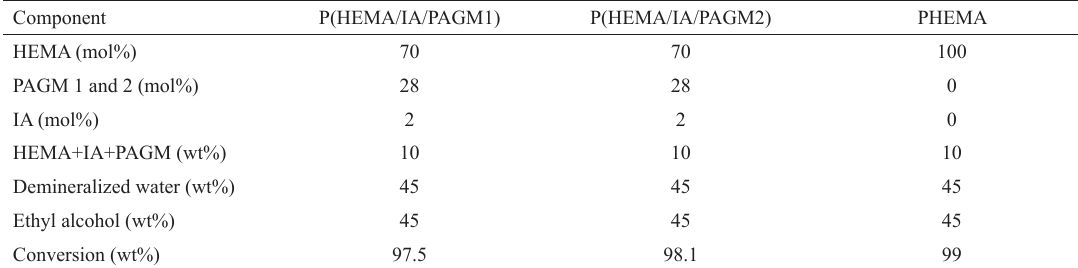
Table 2: Feed compositions for P(HEMA/IA/PAGM) and PHEMA hydrogels.